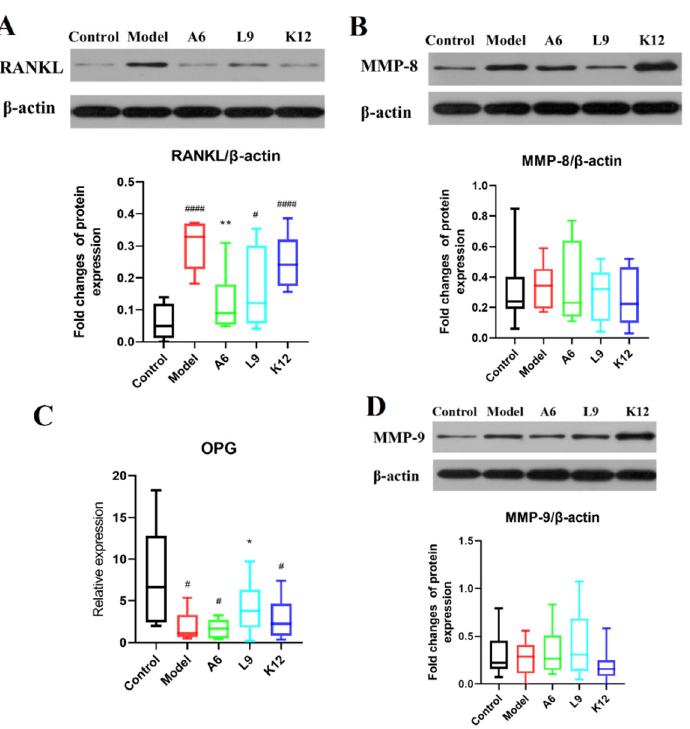
Figure 4. The modulating effect of A6 or L9 on protein expression levels of key biomarkers in gingival tissues. ( A , B , D ) Representative analysis and densitometric quantification of Western immunoblot bands. ( C ) Relative expression of OPG as determined by RT-PCR. Values designated with a superscript * reflect comparisons with the model group, and values with a # are in relation to the control group ( * p and # p < 0.05; ** p < 0.01; #### p < 0.0001).